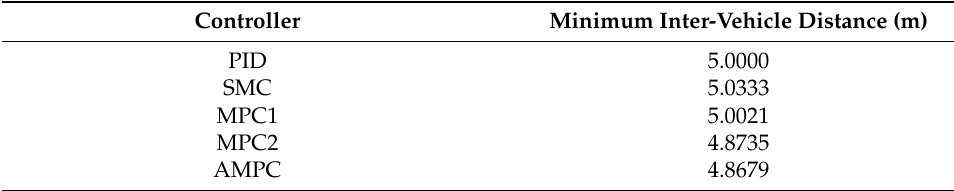
Table 6. Minimum distance between two vehicles under the action of each